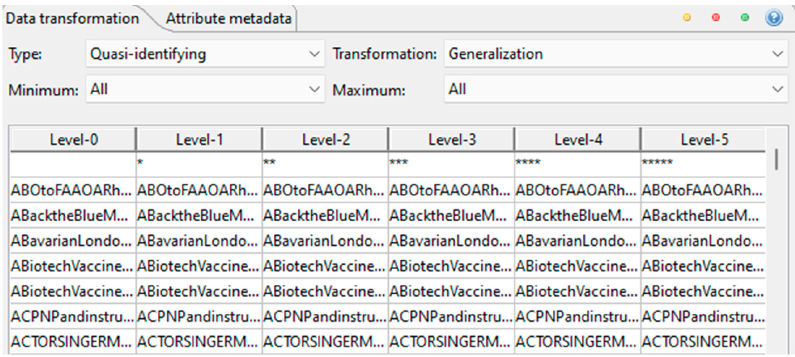
Figure 7. Hierarchy userlocation.